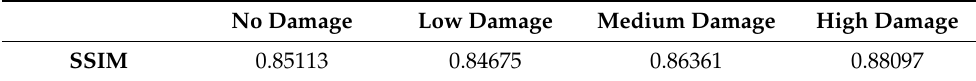
Table 22. SSIM averaged over 150 samples for a modified model (training 10